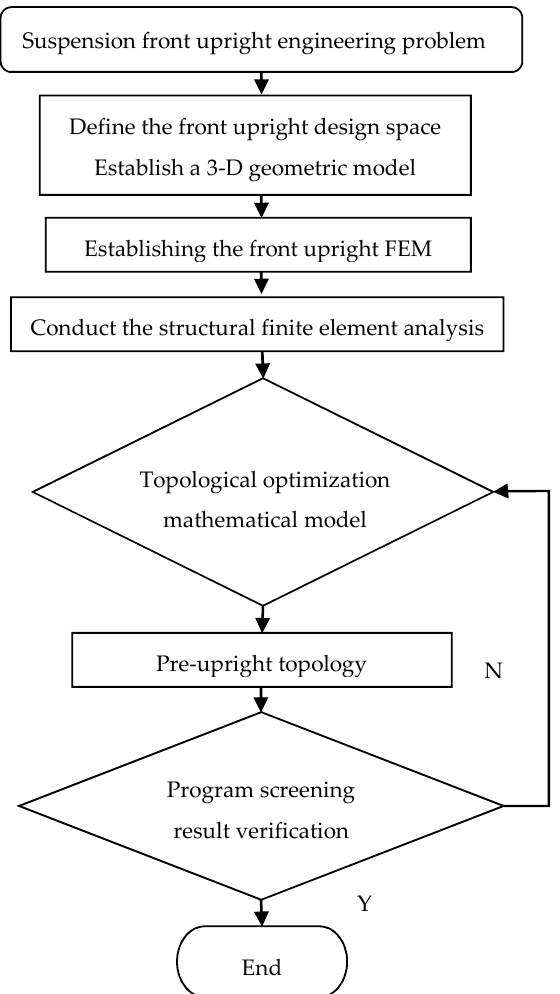
Figure 1. Topology optimization process for suspension front upright.